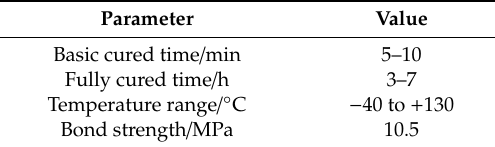
Table 1. Parameters of epoxy resin adhesive.